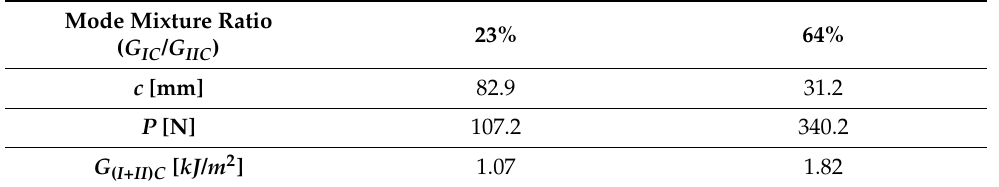
Figure 9. Mixed-mode fracture toughness test results: ( a ) 𝑃 − 𝛿 curve and ( b ) 𝐺 − 𝑎 curve. Table 5. Experimental result of Mixed-mode.